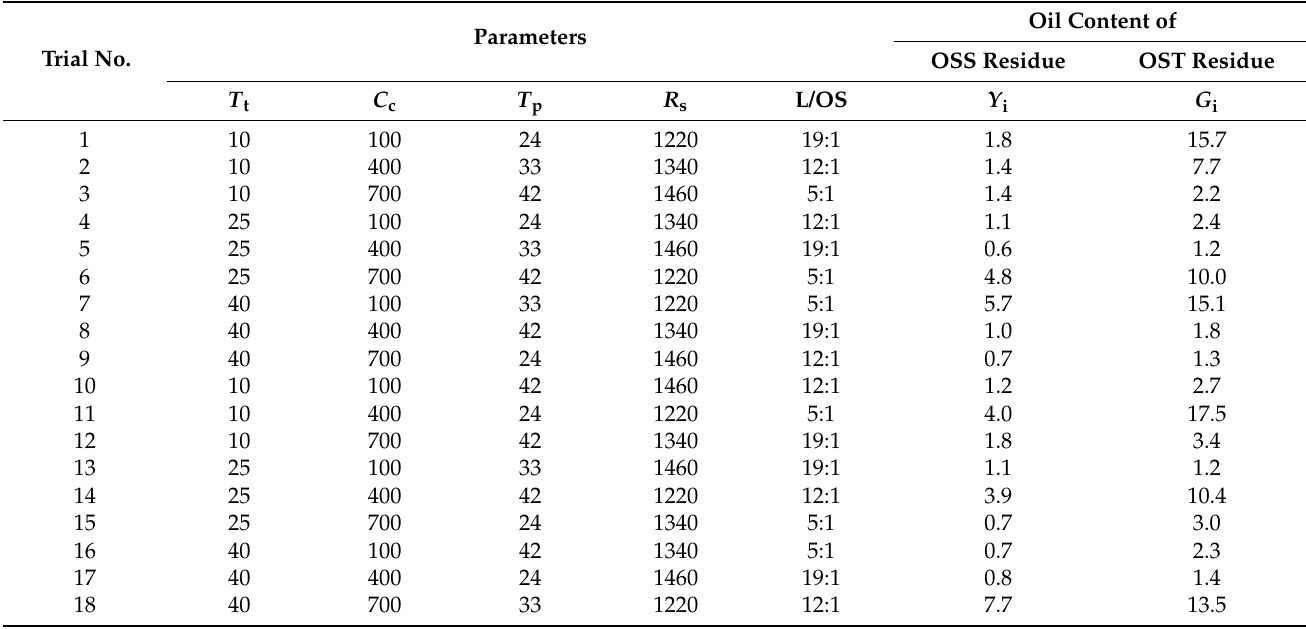
Table 4. Oil content of residue in OA18 matrix.